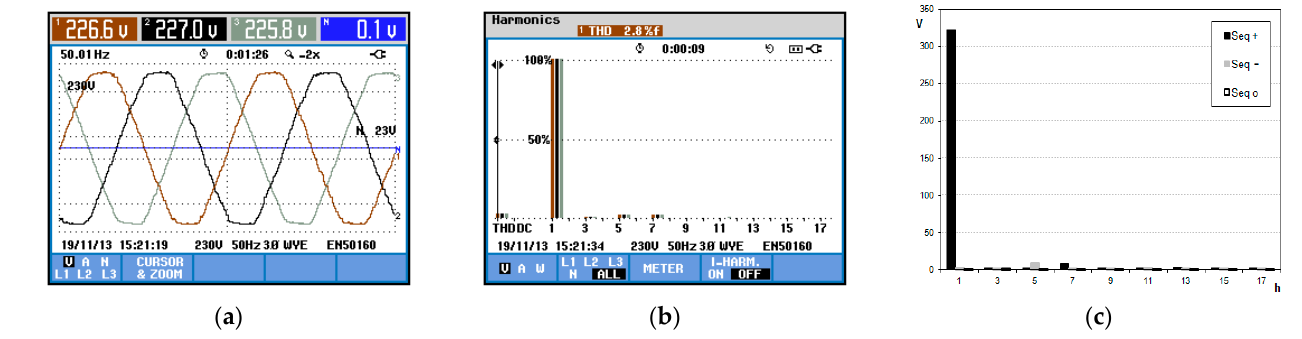
Figure 29. Case 2 - ZSS and three-wire ShAPF operating with balanced loads: ( a ) three-phase voltages; ( b ) harmonic spectrum of the voltages; ( c ) harmonic spectrum of the voltage sequence components (maximum values).